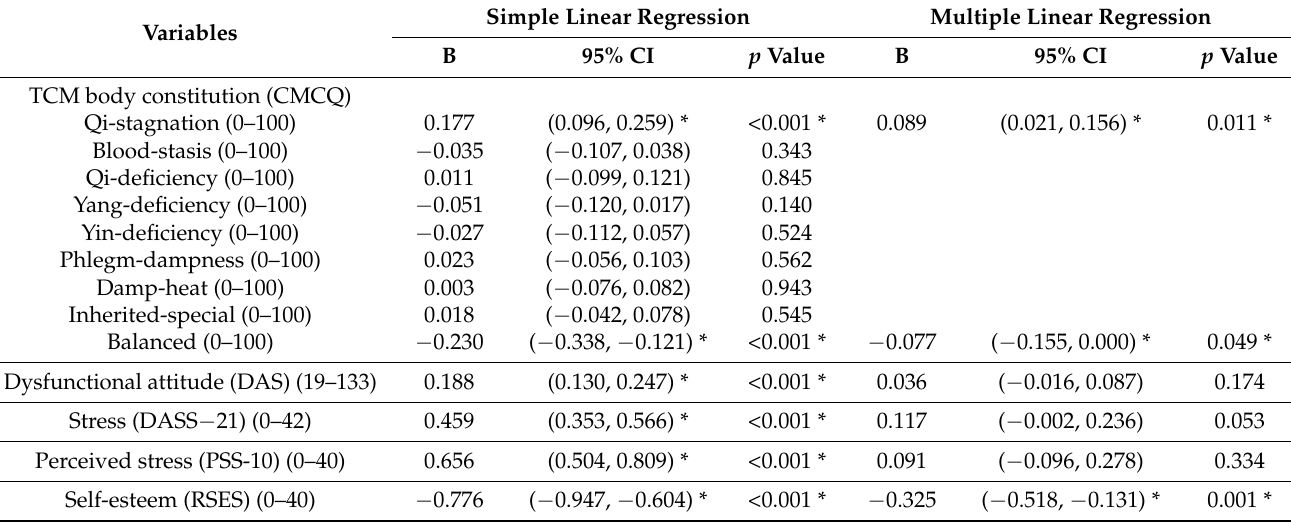
Table 4. Summary statistics and results from the regression